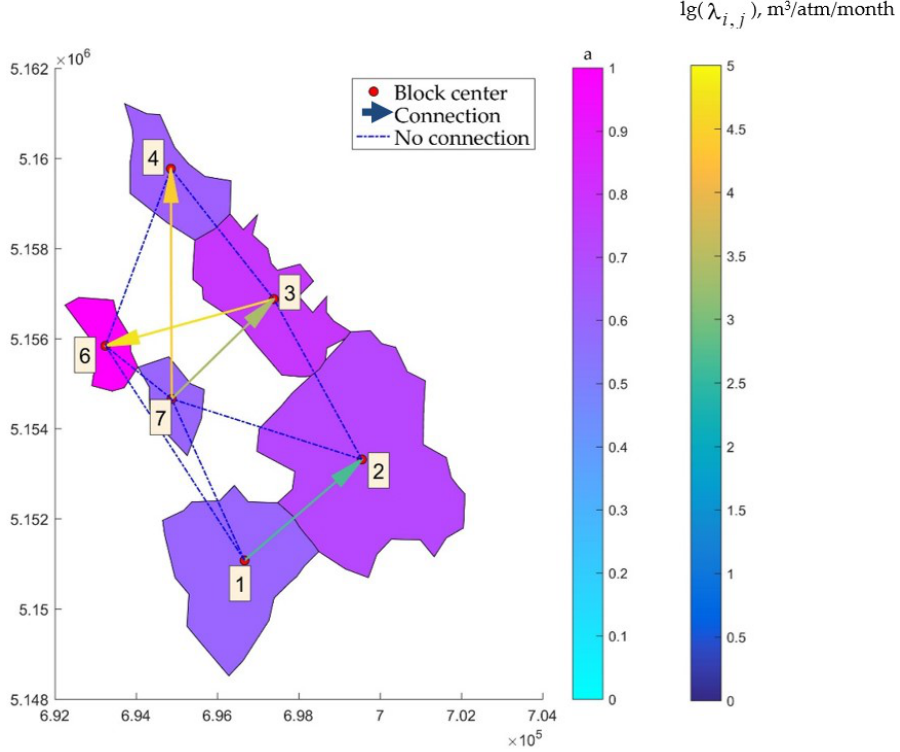
Figure 6. Schematic arrangement of blocks and representation of transmissibilities between them.